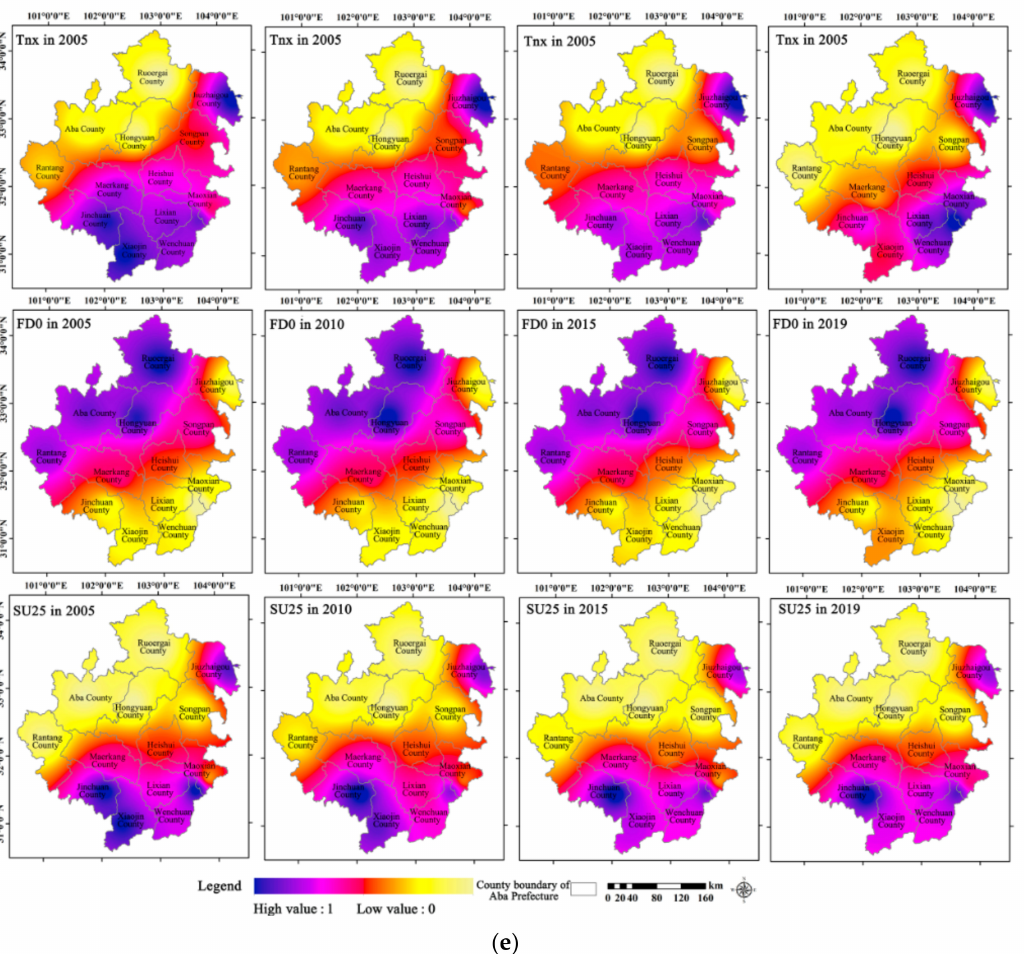
Figure 4. Spatial distribution map of exposure indexes. ( a ) density of geological hazards, ( b ) density of population, ( c ) fertilizer application amount, ( d ) per capita gross domestic product, and ( e ) extreme climate